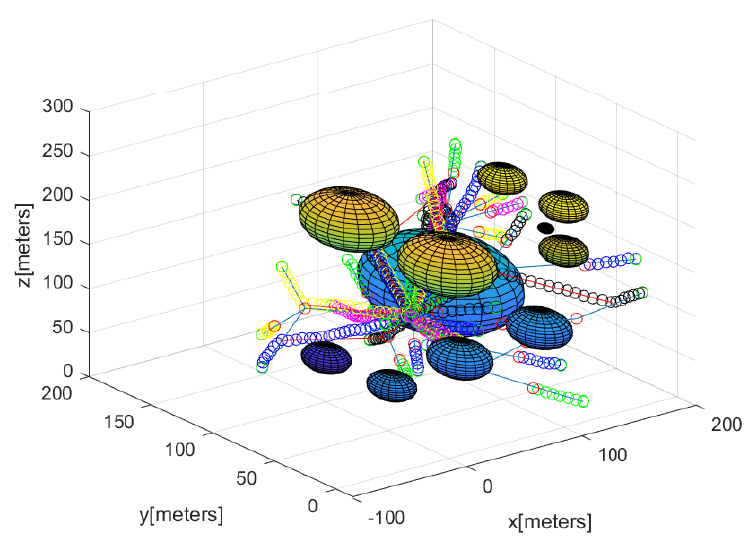
Figure 10. Every UUV’s maneuver once the rendezvous is completed (the discard approach is utilized). Every UUV’s maneuver is illustrated as circles with a distinct color. A total of 25 broken UUVs are illustrated with red circles. Obstacles are plotted with spheres.